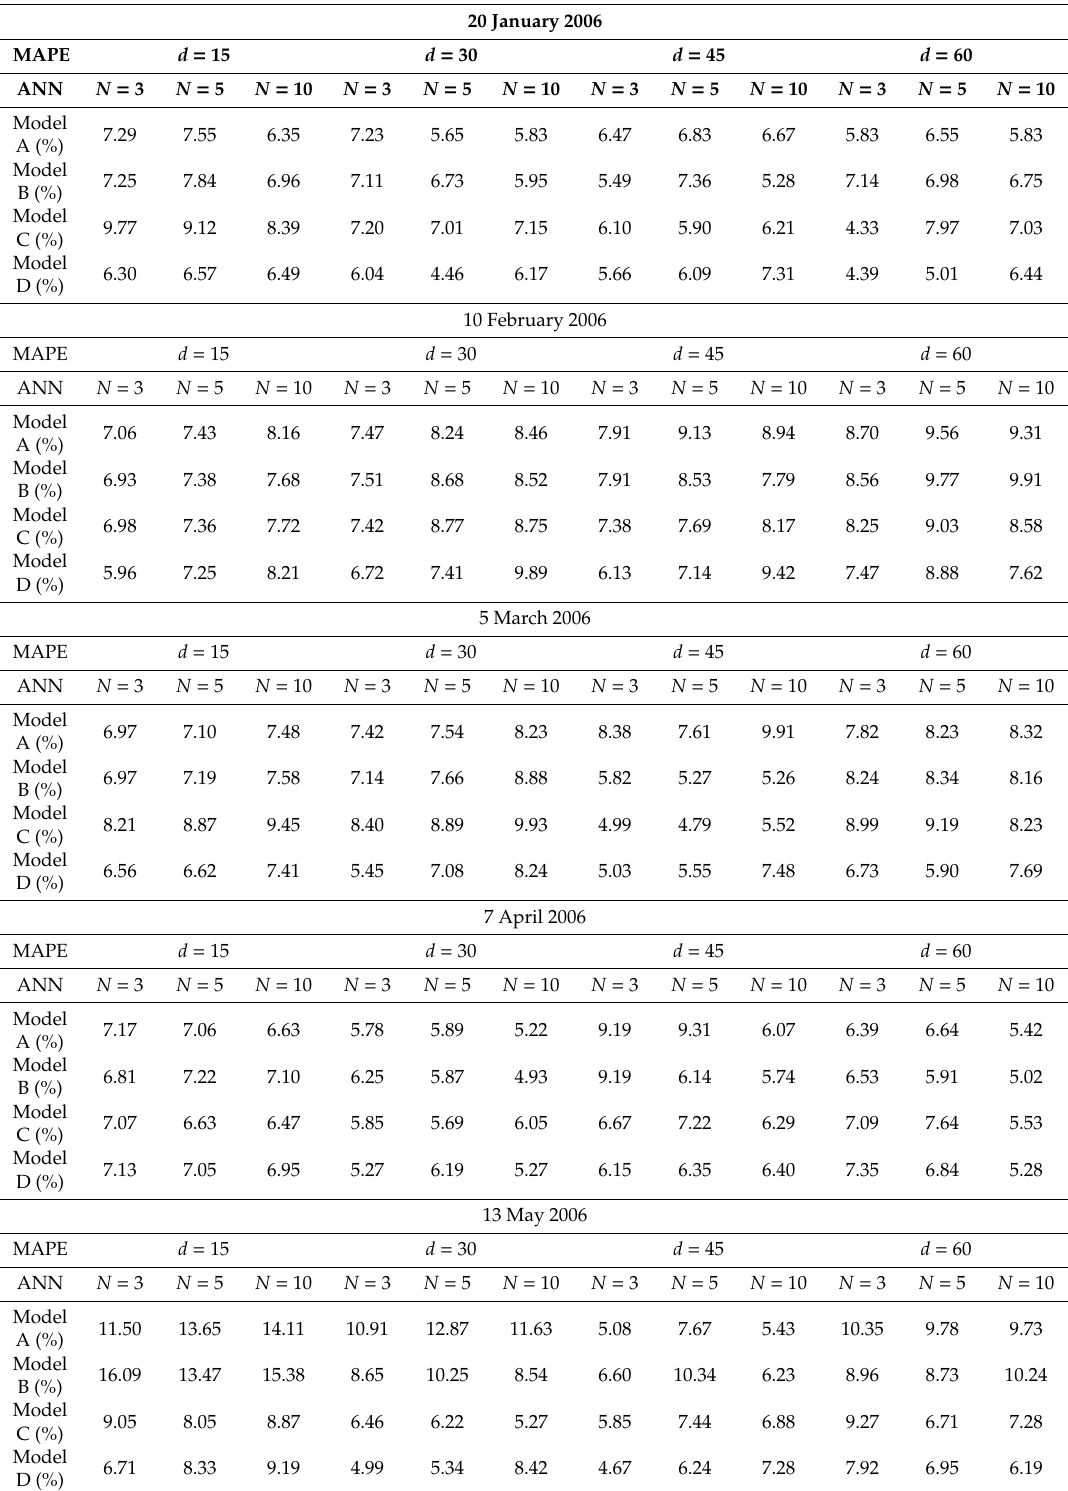
Table 4. Neural network for forecasting electricity price of